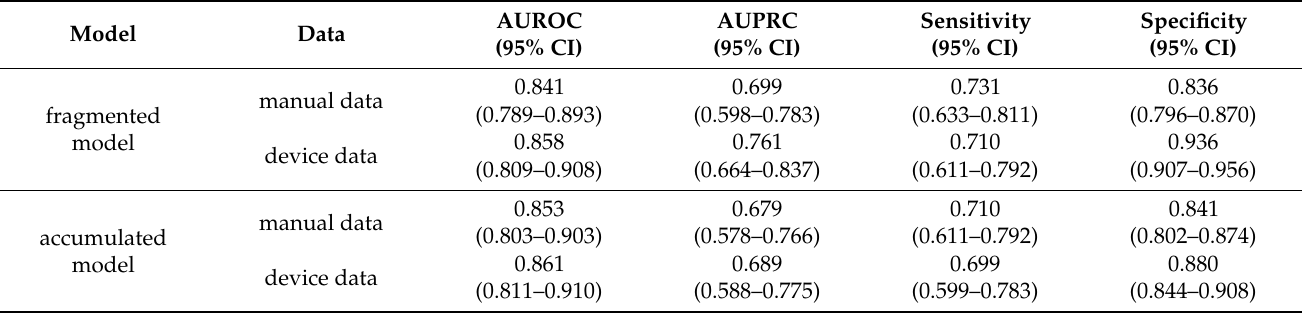
Table 2. Predictive performance of each model .